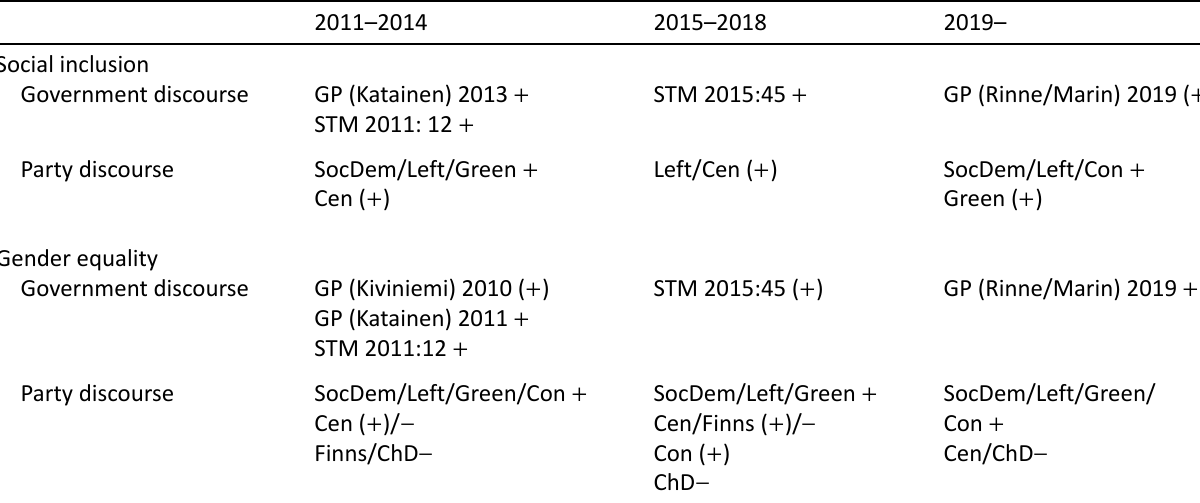
Table 1. Overview of government and party discourses regarding parental leave in Finland during the